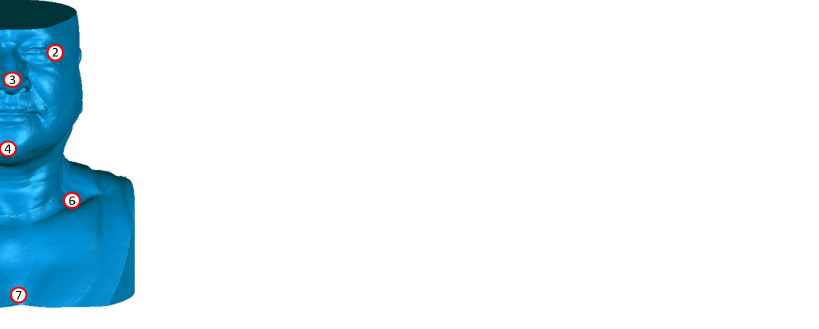
Figure 21. Positioning markers representing the seven points selected for quantification. Table 1. Displacement error for the positioning markers between the 3D geometry and the 3D ther- mal model.